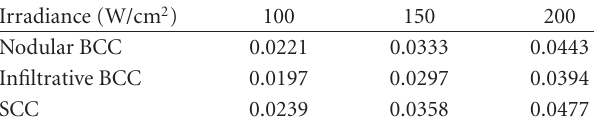
Table 2: Total energy (J) in the three skin pathology samples for di ff erent